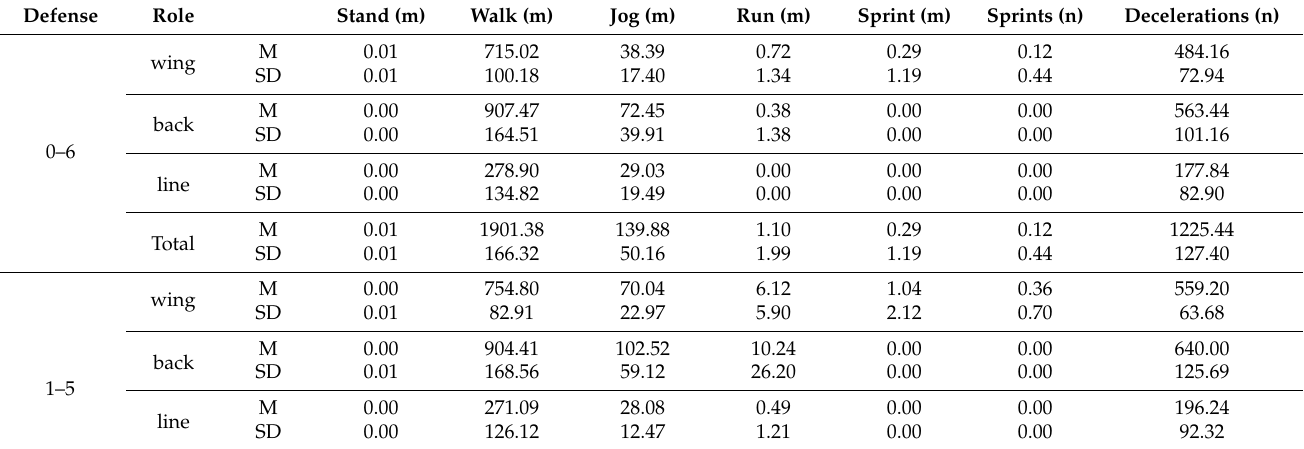
Table 2. Mean ± SD physical demands performed as a function of defensive organization and players’ role, normalized per 10-min of